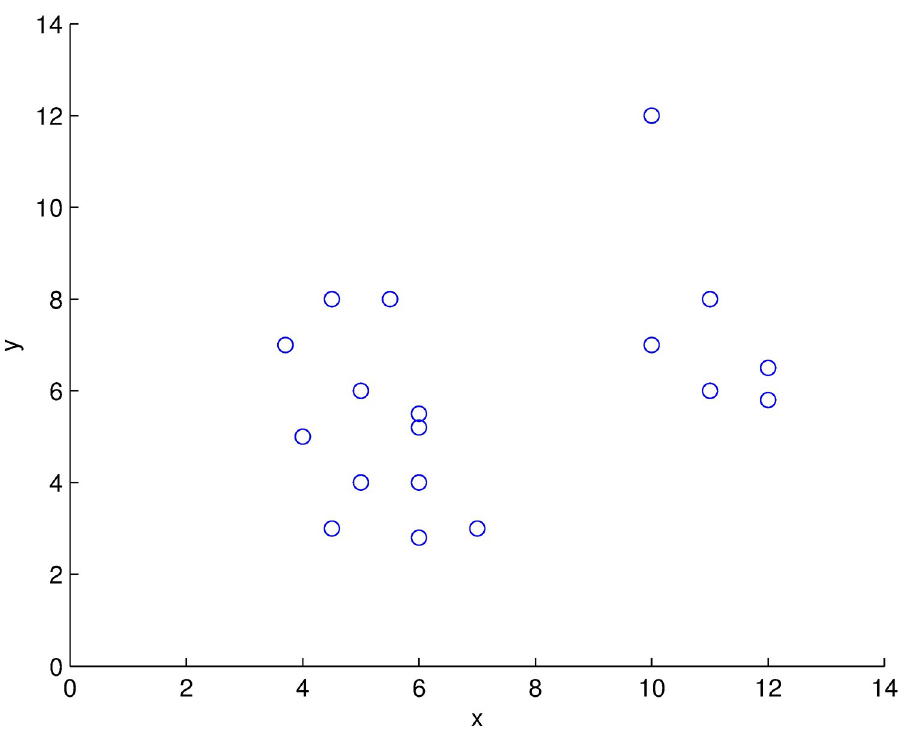
Fig 2. The data points waiting for being